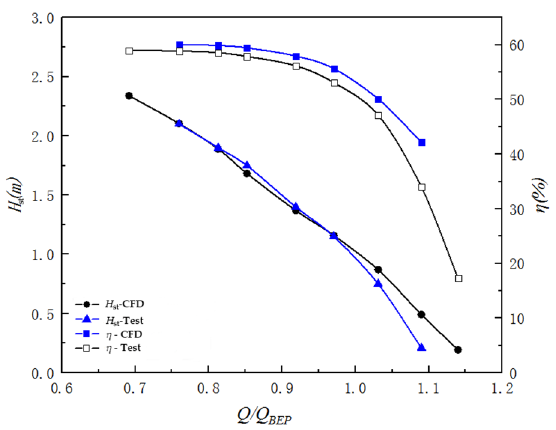
Figure 24. Comparison of hydraulic performance between CFD and test (Case 12).